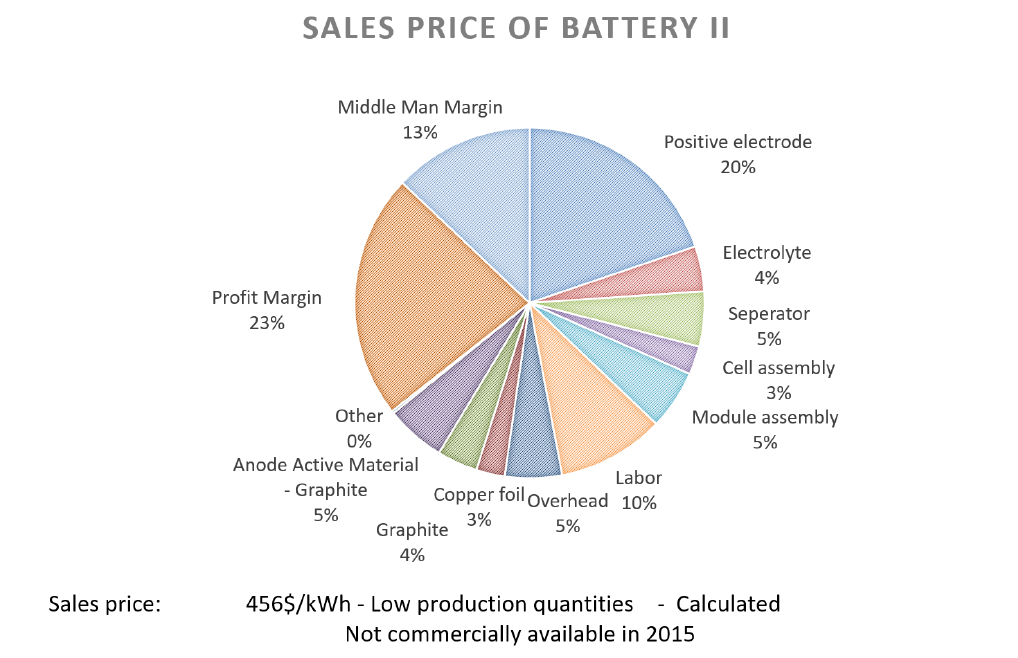
Figure 9. Sales price of battery